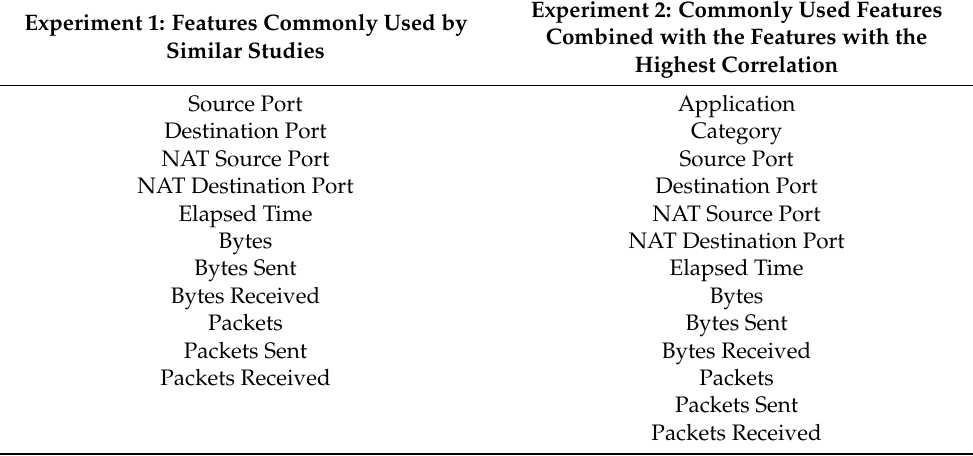
Table 3. Set of features used in each experiment. Experiment 2: Commonly Used Experiment 1: Features Commonly Used by Similar Studies